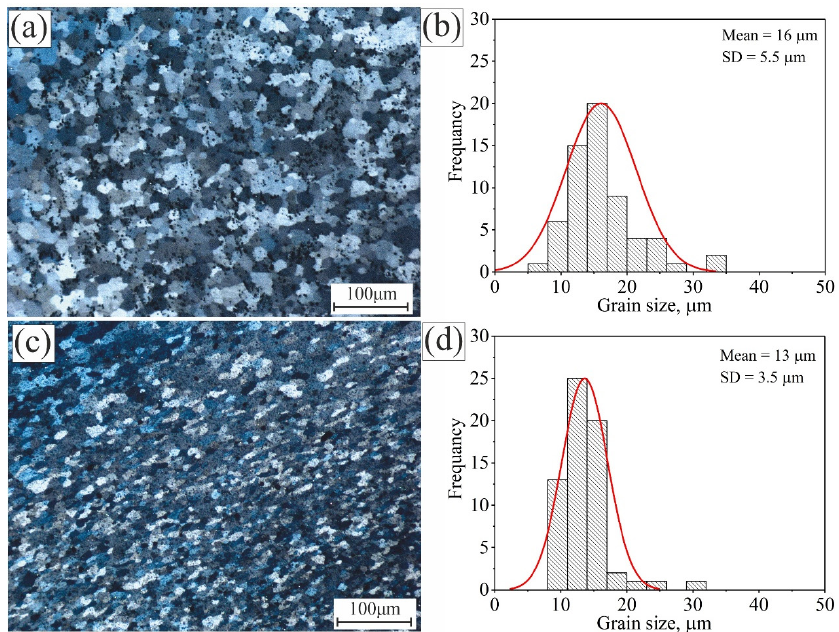
Figure 4. The microstructure and the grain size distribution in the SZ after the first pass of the investigated alloys: ( a , b ) Al 5052 and ( c , d ) Al 5052/TiB.